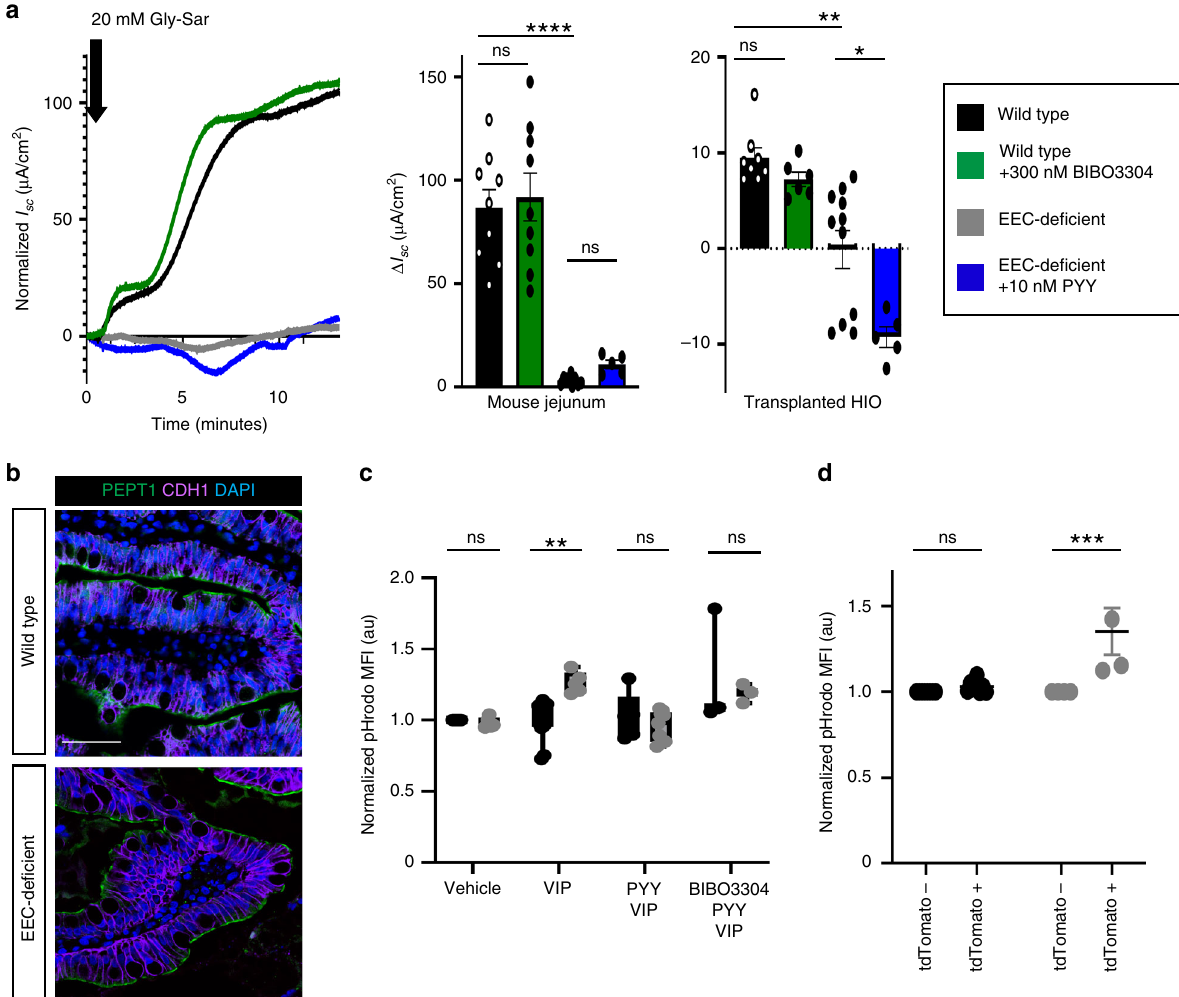
Fig. 3 H + -coupled dipeptide absorption is impaired in EEC-de fi cient small intestine. a EEC-de fi cient human and mouse small intestine did not respond to the dipeptide Gly-Sar after exposure to VIP (mouse, n = 9 wild-type, n = 6 mutant, **** P < 0.0001; human, n = 11 wild-type, n = 5 mutant, ** P = 0.006). Pre-treatment of EEC-de fi cient tissue with exogenous PYY (mouse, n = 6, ns; human, n = 5, * P = 0.03), or of wild-type tissue with BIBO3304 (mouse, n